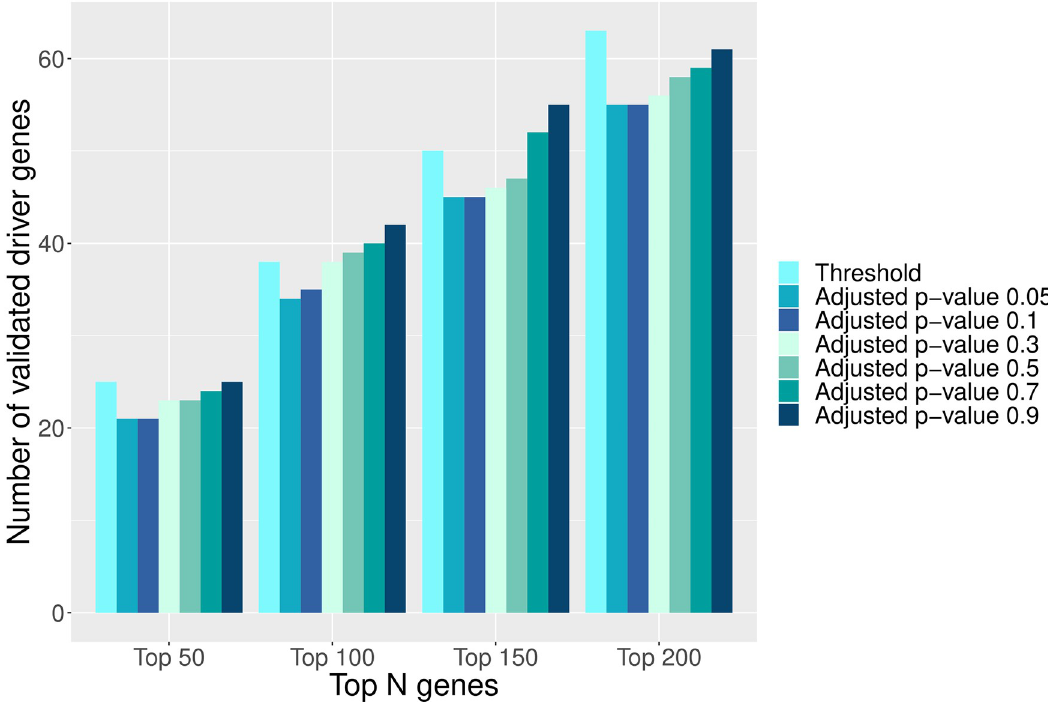
Fig 8. CBNA using different adjusted p-value cutoffs. The cancer drivers predicted by CBNA with different adjusted p-value cutoffs are validated by the CGC. Each bar in the figure shows the number of validated coding cancer drivers of CBNA with a cutoff.